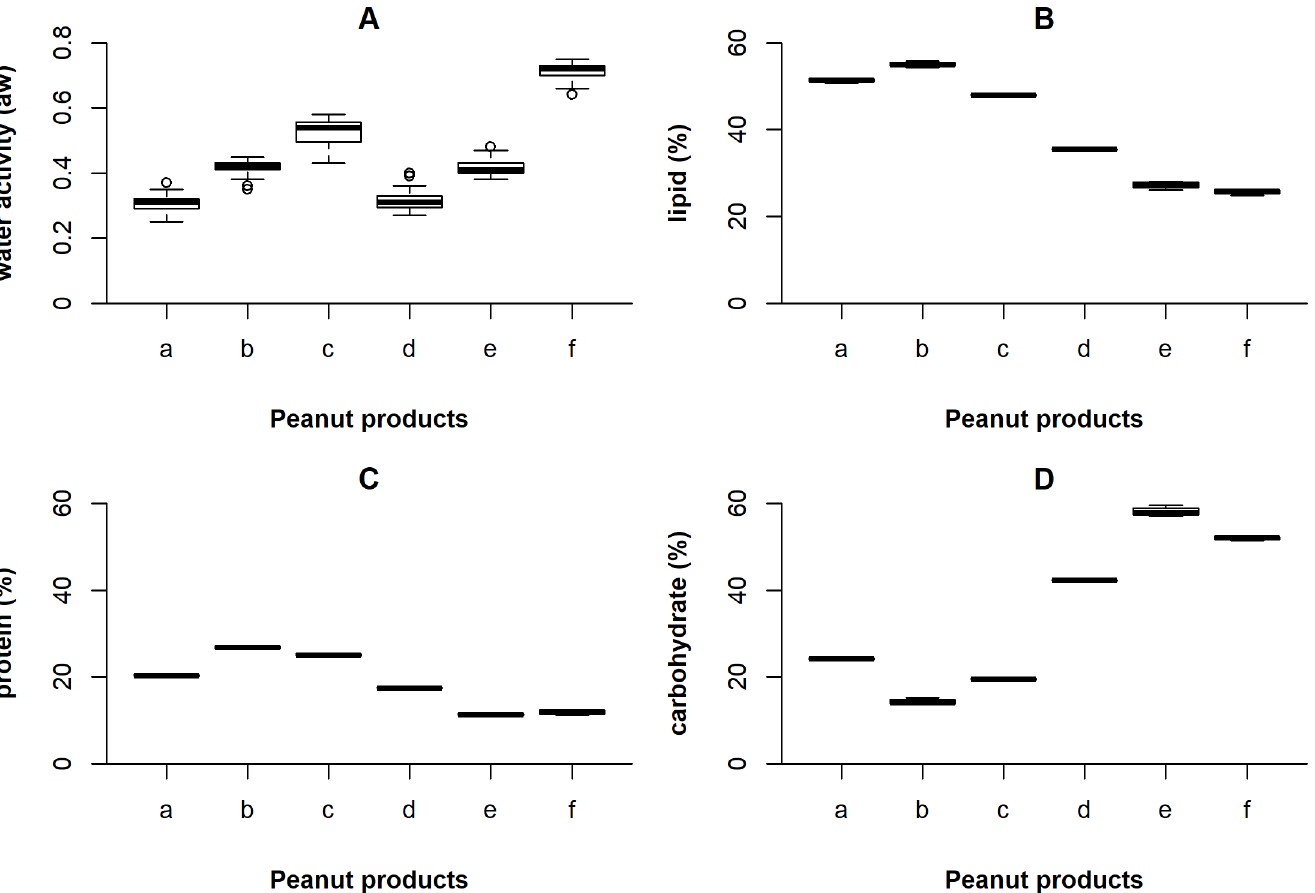
Fig 1. Box-whisker plot of the water activity (A), lipid content (B), protein content (C) and carbohydrate content (D) of raw in shell peanuts (a), roasted peanuts (b), unblanched peanut kernels (c), peanut brittle (d), paçoca (e) and pé-de-moça (f). Maximum and minimum are denoted by whiskers, 75 th and 25 th percentile are denoted by box, and median is the line inside the